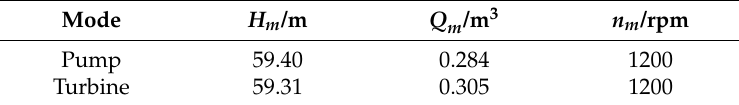
Table 1. Design parameters of a model pump-turbine.